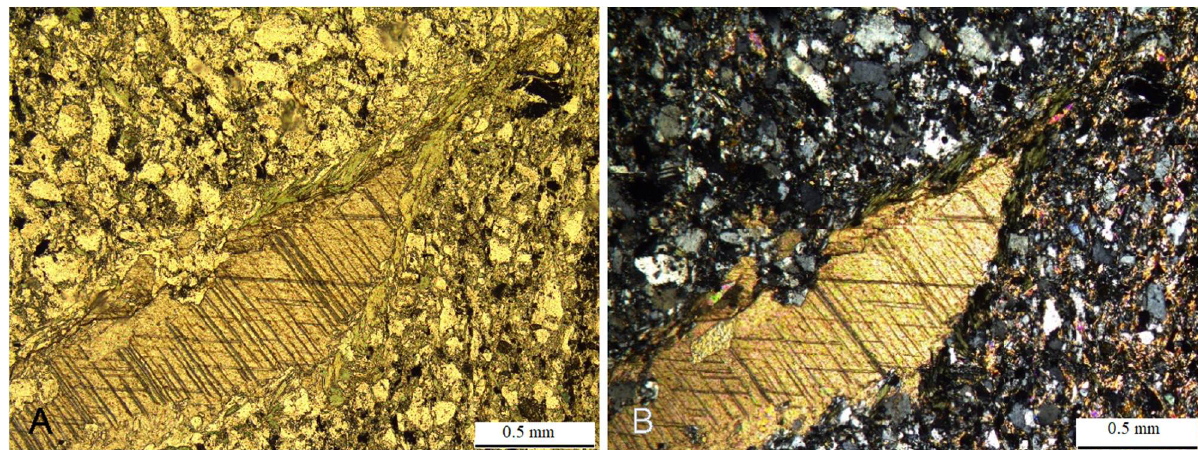
Figure 5. Thin section of a moraine sample within a large particle of calcite: ( A ) parallel Nicoli and ( B ) crossed Nicoli.